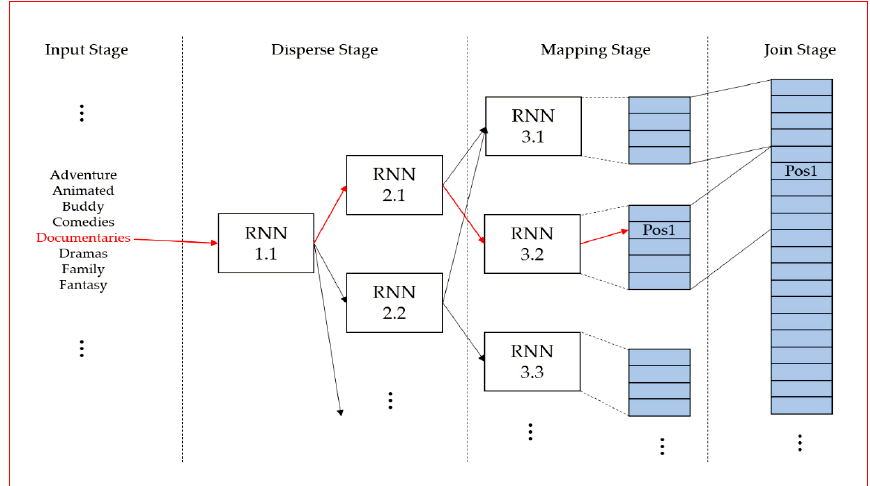
Figure 5. Learned Inverted Index [8]: The RNN model received the preprocessed data string as an input and predicts the position of the data in the leaf RNN.